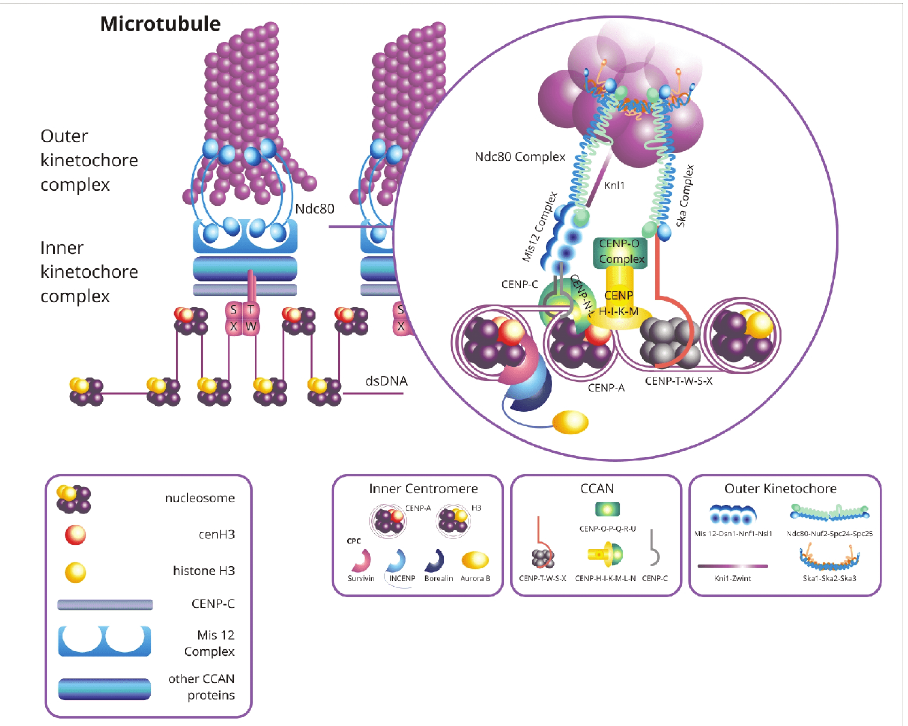
Figure 1. Model of the vertebrate mitotic centromere/kinetochore complex. Kinetochores assemble on chromatin marked by CENP-A containing nucleosomes. CENP-A nucleosome binds chromosomal pas- senger complex (CPC), which consists of four proteins: kinase Aurora B, INCENP, Survivin and Borealin. The kinetochore is composed mainly of CCAN (constitutive centromere-associated network) and Knl1- Mis12-Ndc80 complexes. The presence of CENP-A allows the recruitment of CCAN, which is a complex consisting of 16 centromeric proteins: CENP-C, CENP-T-W-S-X, CENP-H-I-K-M, CENP-N-L and CENP-O-P-Q-R-U. CENP-C and CENP-N bind CENP-A. The CENP-T-W-S-X complex creates a unique nucleosome-like structure that allows DNA binding in centromeric chromatin. CENP-N-L and CENP-H-I-K-M have regulatory roles. CENP-H-I-K-M-L-N help recruit CENP-C. CENP-C binds to the Mis12 complex, which then recruits Knl1 proteins interacting with microtubules and the Ndc80 complex. Ndc80 – kinetochore complex component (the complex consists of Ndc80-Nuf2-Spc24-Spc25 proteins); cenH3 – centromere specific histone 3 or histone H3 variant found at the centromere, CENP- A – centromere protein A, centromere specific histone 3 or histone H3 variant found at the centromere; CENP-C – centromere protein C; Mis 12 Complex – complex of the core kinetochore (the complex consists of Mis12 - Dsn1 - Nnf1 - Nsl1 proteins) ; Knl1 – kinetochore scaffold 1; Zwint – kinetochore proteins; CCAN – constitutive centromere-associated network, CPC – chromosomal passenger complex (consist- ing of Borealin, Survivin, INCENP, and the Aurora B kinase), INCENP – Inner Centromere Protein; Ska Complex – spindle and kinetochore associated (the complex consists of Ska1-Ska2-Ska3